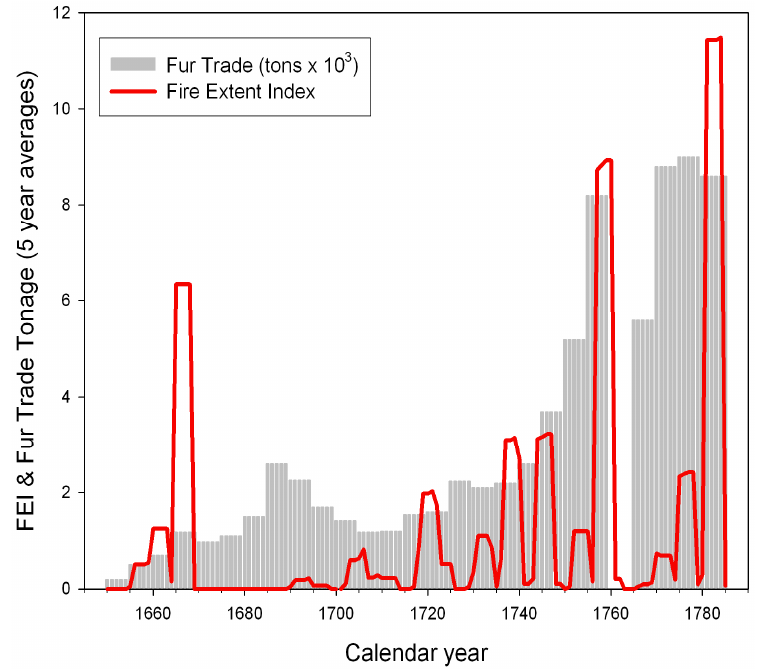
Figure 7. Trends in Great Lakes fur trade per five-year period [23] plotted with a five-year moving average of the number of fires at the study sites. The 1760–1765 trade data is missing from Harris [23]. The similar trends in trade and fire regimes support the 1650–1785 increase in human influence as calculated by the AnthroFire Index.